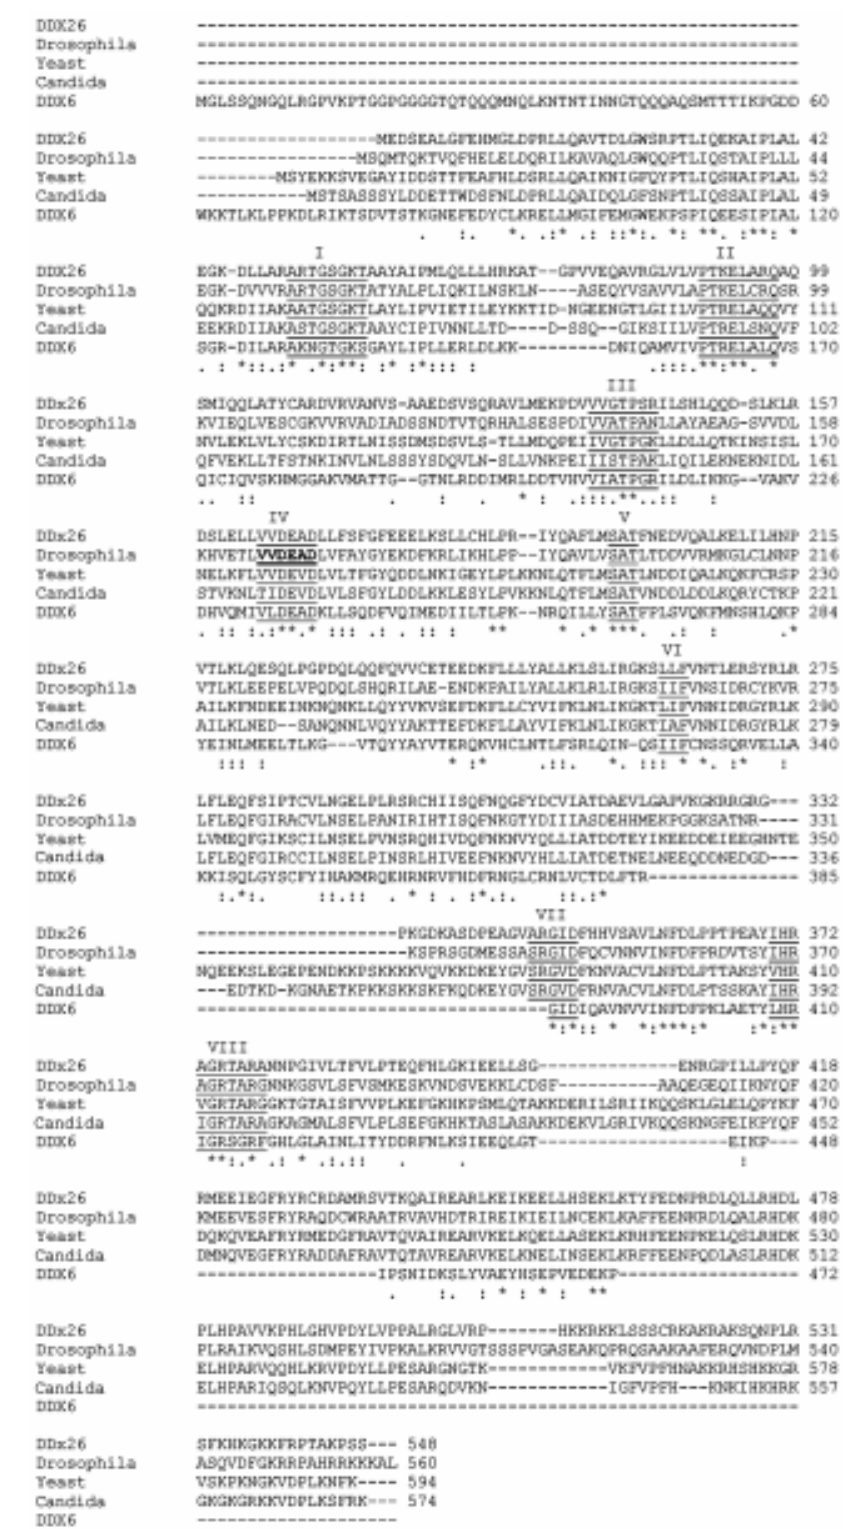
Figure 2. Alignment of the predicted amino acid sequence of DDX26 and RNA helicases from Drosophila (AF017777), yeast (NP013378), Can- dida (AL033391) and the human DDX6 RNA helicase (NM004397). Conserved DEAD-box RNA helicase motifs are underlined and marked from I to VIII in the amino acid se- quences. Numbers on the right cor- respond to residue number of the * Identical or conserved resi- protein. dues; conserved amino acid substi- tution; semi-conserved amino acid